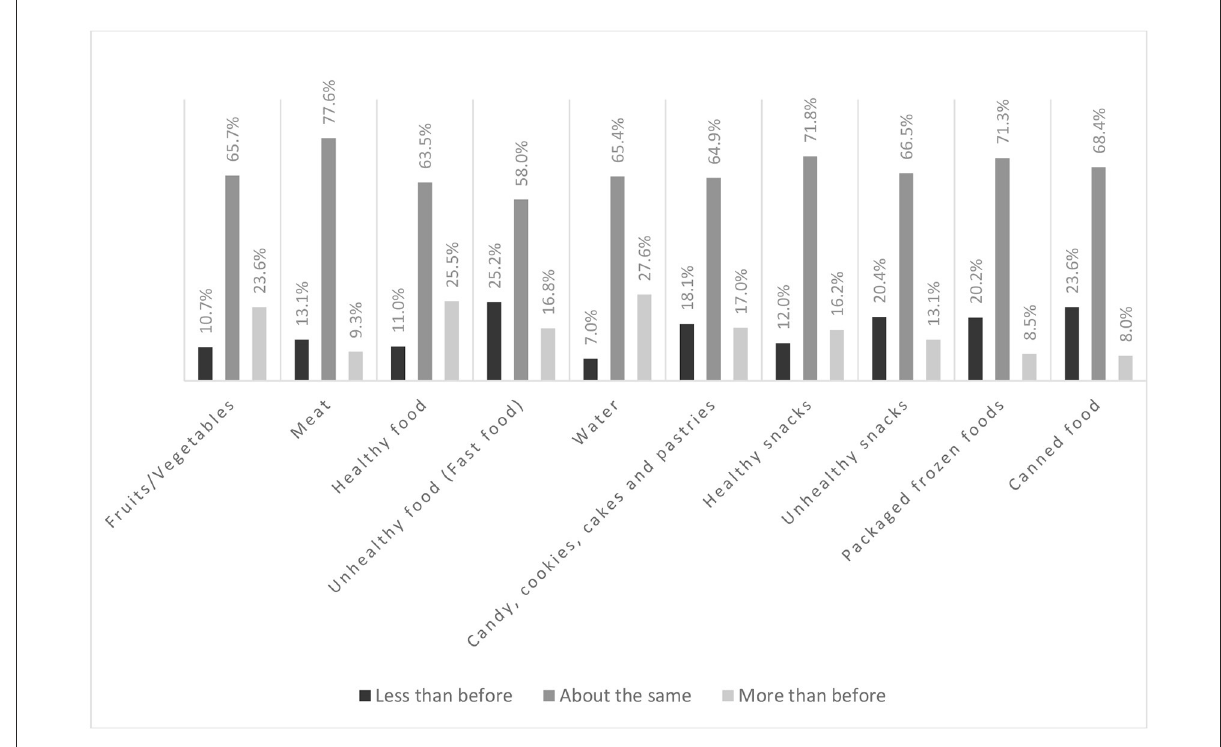
FIGURE2 Changes in dietary habits after the availability of the COVID-19 vaccine.